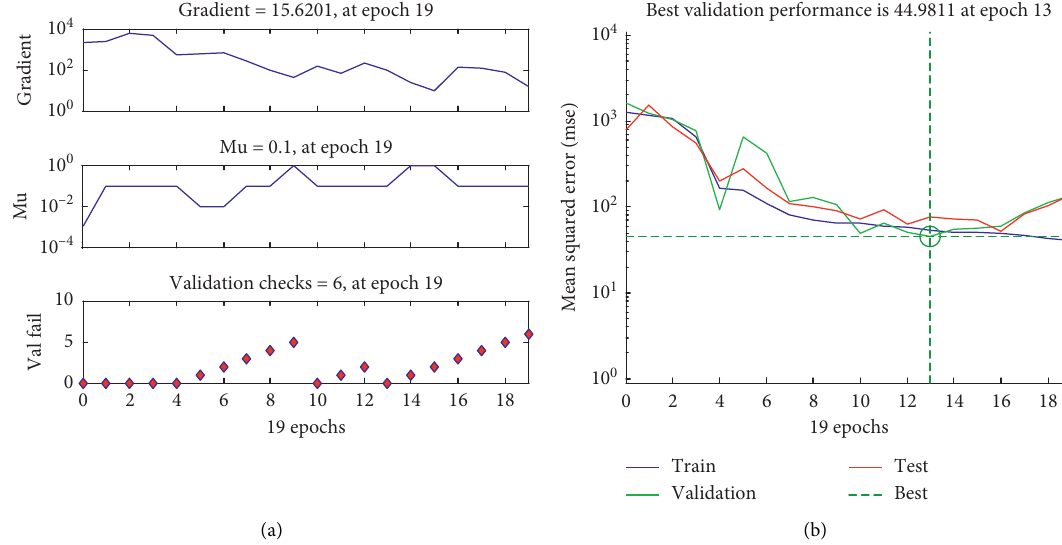
Figure 5: Information about the selected ANN model. (a) Training. (b)